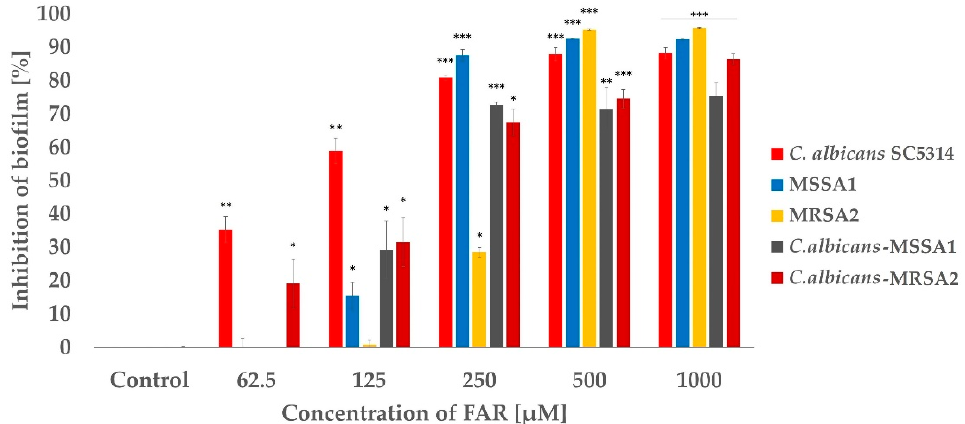
Figure 2. Inhibitory effect of FAR on single-species and mixed biofilms formed by C. albicans -MSSA1 and C. albicans -MRSA2 determined by MBIC 50 using the XTT assay. Optical density (OD 490 ) of the suspensions was determined after 48 h cultivation of biofilms in the presence of different concentrations of FAR; the control sample was without FAR. Percentage of growth inhibition was calculated from the OD 490 values of samples compared to the inhibition of the control sample set to 0%. Data represent the average of 3 independent experiments performed in triplicate. A p < 0.05 (*) was considered statistically significant; p < 0.01 (**) was considered highly significant; p < 0.001 (***) was considered extremely significant.